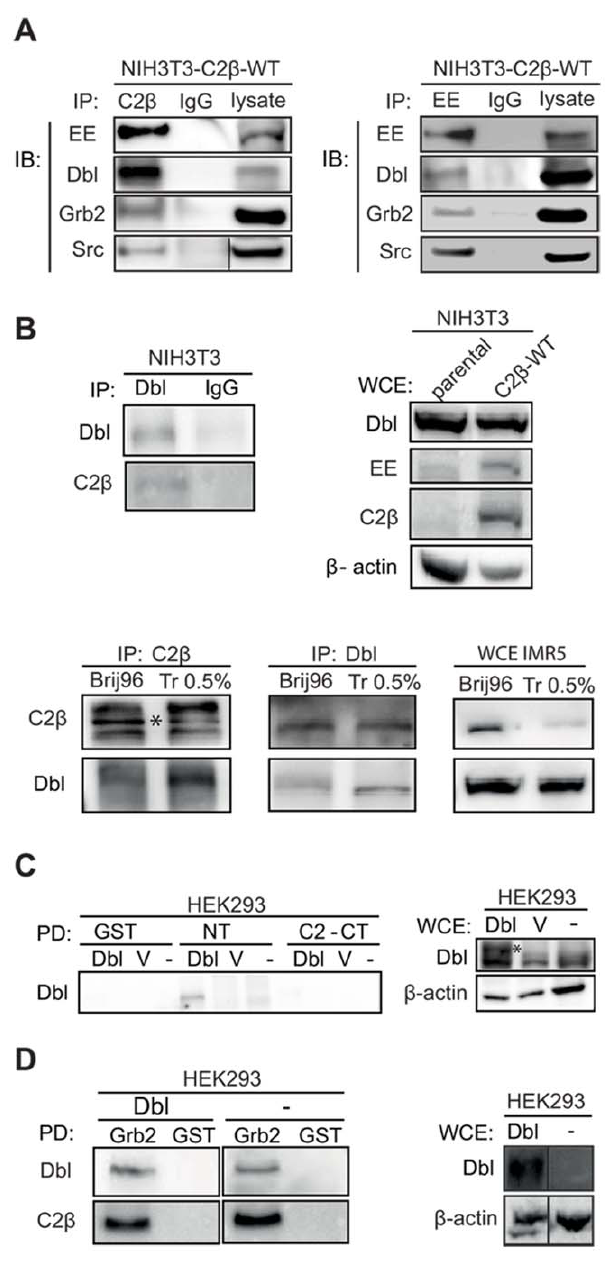
Figure 1. PI3KC2 b interacts with Dbl GEF for Rho GTPases. (A) Lysates of NIH3T3 cells stably overexpressing wild-type Glu-PI3KC2 b (NIH3T3-C2 b -WT) were immunoprecipitated (IP) with an anti-C2 b , anti- Glu (EE) tag, anti-Dbl or control IgG antibody. PI3KC2 b interaction with the endogenous Dbl, as well as Grb2 and Src was detected by immunoblotting (IB) with the indicated antibodies. (B) Complex of endogenous PI3KC2 b and Dbl was immunoprecipitated from the whole cell extract (WCE) of the parental NIH3T3 cells and IMR5 neuroblastoma human cancer cells with anti-Dbl, anti-C2 b and control IgG antibody. Samples were subjected to western blot analysis with the indicated antibodies. In the case of IMR5 cells Triton 0.5% and Brij96 1% lysis buffers were used, while NIH3T3 cells were lysed with Triton 1%. Asterisk indicates PI3KC2 b . (C) Interaction between the PI3KC2 b and Dbl was examined by the pull-down (PD) of PI3KC2 b GST-fused N-terminal and C2 C-terminal domains in HEK293 cells transfected with HA-proto- Dbl (Dbl), pcDNA3 empty vector (V) or untransfected control (-). Complex formation was shown by immunoblotting with anti-Dbl antibody. Asterisk indicates ectopically expressed (HA-tag) Dbl.